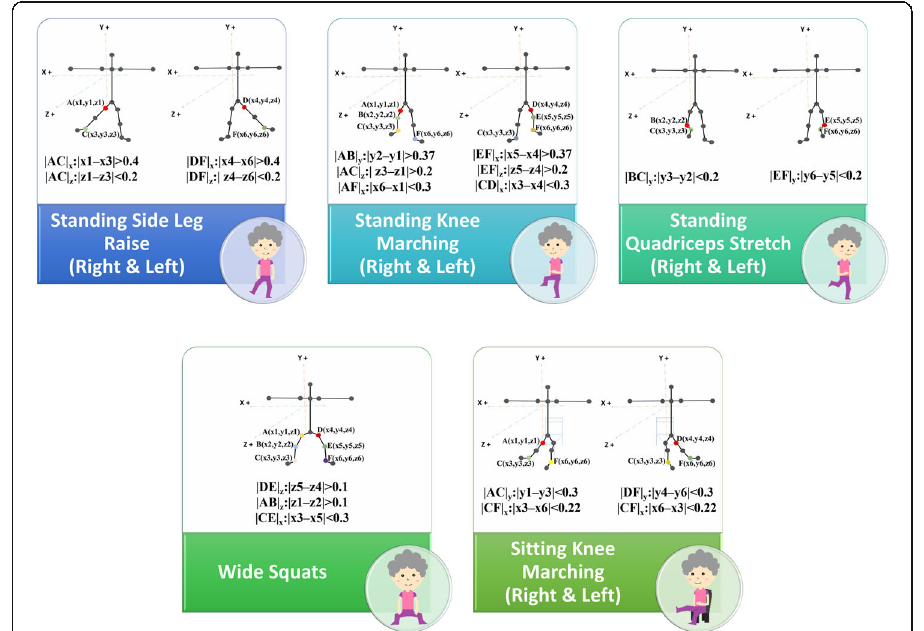
Fig. 1 The judgment mechanism for the five types of movements of the elders ’ functional fitness by using gesture